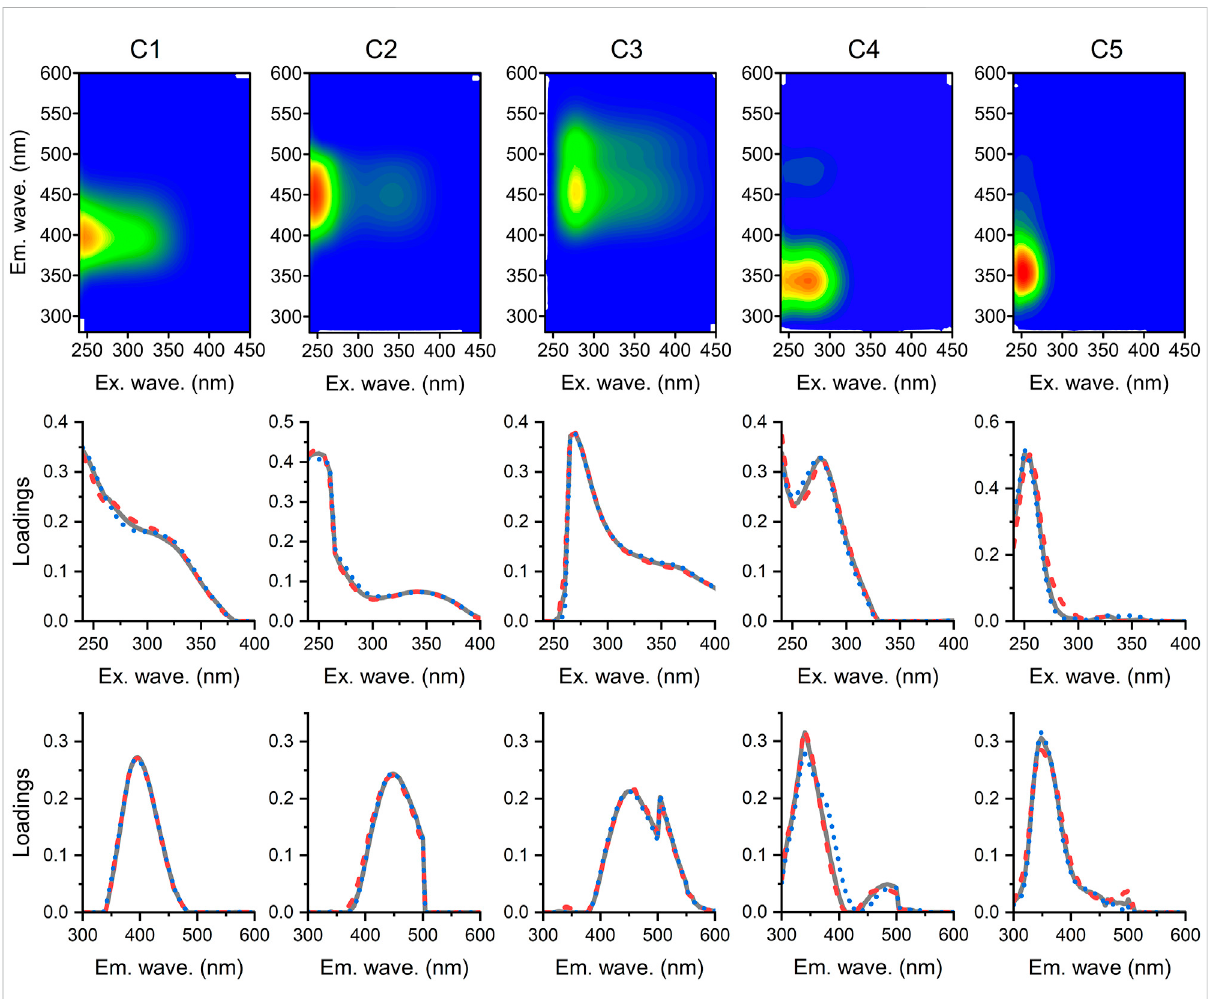
FIGURE 3 Fluorescencesignatures of fi ve PARAFAC components (C1 – C5) identi fi edinthegroundwater and river water EEMs dataset (toprow). Line plots show split-half validations in which each component ’ s excitation (middle row) and emission loadings (bottom row) are produced from two independent halves of the dataset (dashed and dotted lines) and the complete dataset (solid